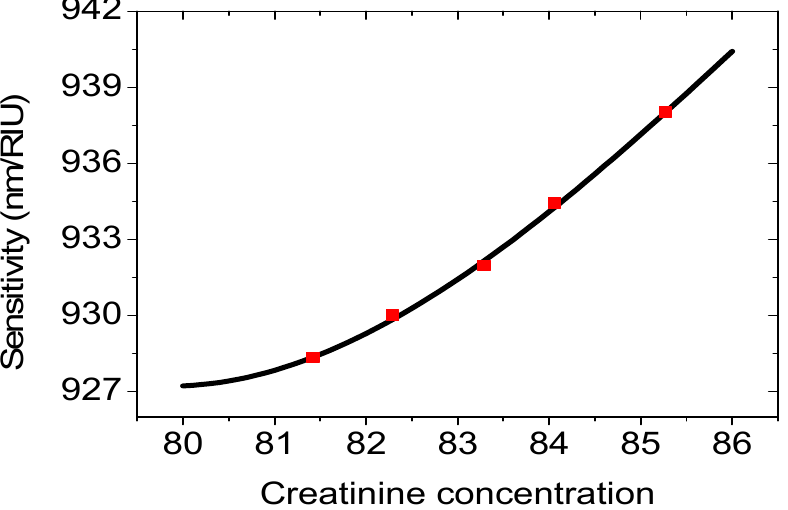
Figure 11. The sensitivity as a function of creatinine concentration for a proposed ternary photonic crystal at θ 0 = 60°, h f = 5.5 µm, and N = 4. Table 6. The present study’s sensitivity in comparison to the most recent biosensors that have been published. Techniques/Structures